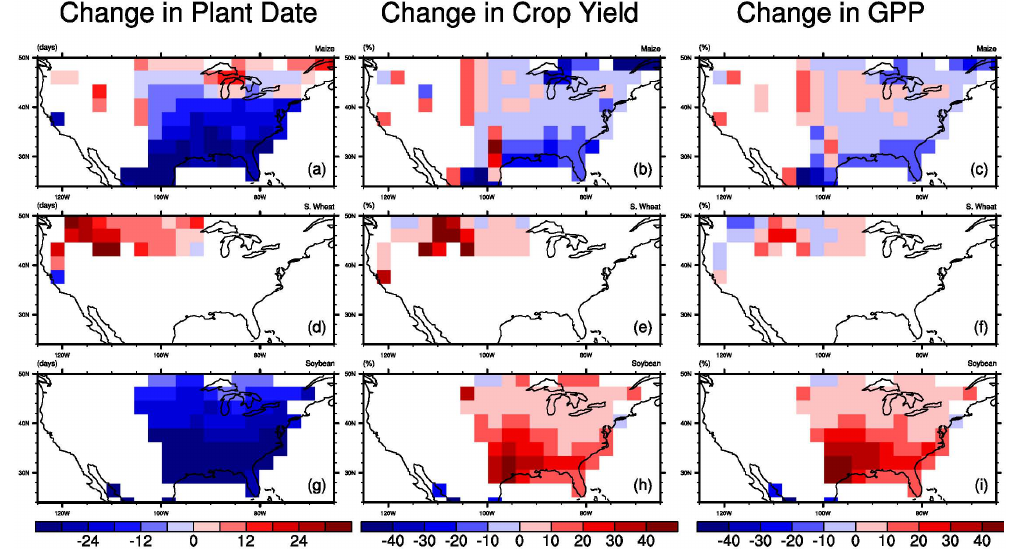
Fig. 13. The left column is the change in planting date (days), represented by the difference between LowPTEMP and CROP for (a) maize, (d) spring wheat, and (g) soybean. The center and right columns are the percent change in crop yield for (b) maize, (e) spring wheat, and (h) soybean and the GPP for (c) maize, (f) spring wheat, and (i) soybean resulting from new planting dates.